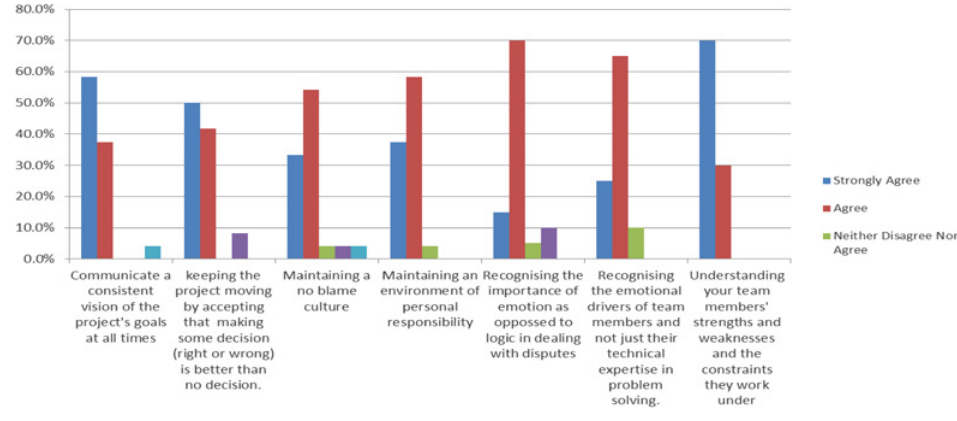
The position of panel members on commentary regarding success factors associated with